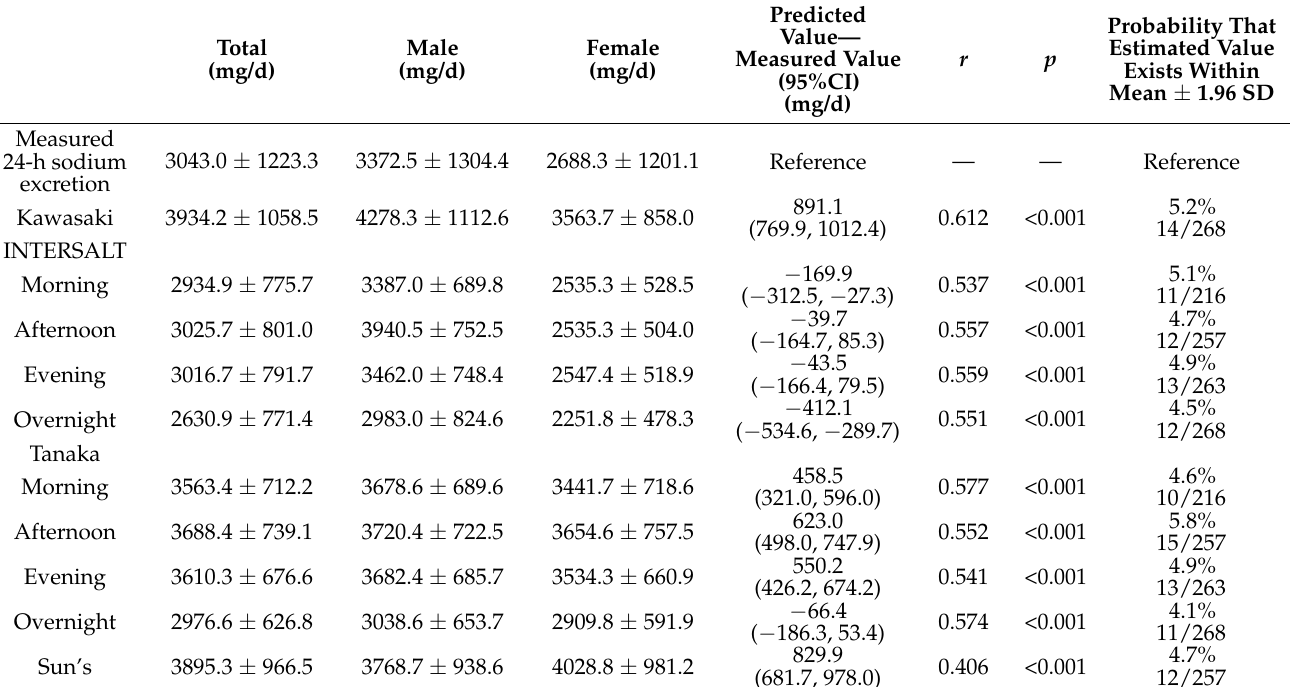
Table 3. Comparison of the average level of daily sodium intake estimated by the four methods with the actual measured values in